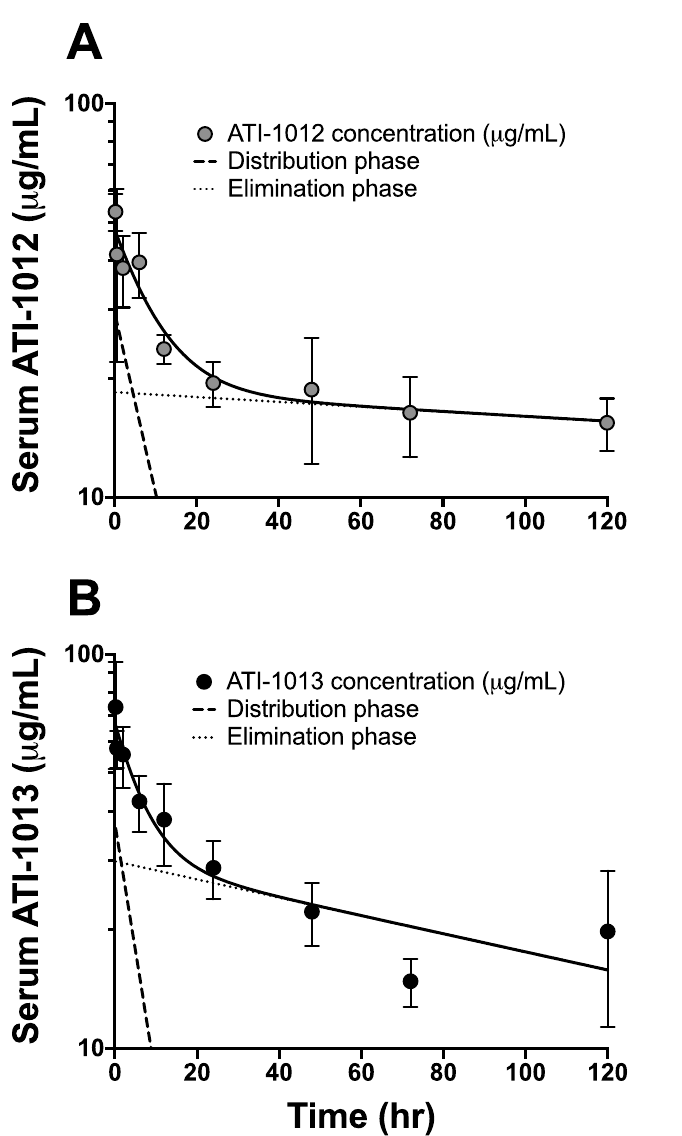
Fig 4. Pharmacokinetics of ATI-1012 and ATI-1013 in rats. Female SD rats were obtained with a jugular venous catheter in place. Rats (n = 3/group) received 5 mg/kg i.v. ATI-1012 (Panel A) or ATI-1013 (Panel B) via tail vein. Blood (0.4 mL) was collected into serum separator tubes via the jugular catheter at pre-dose, at 10 and 30 min, and at 2, 6, 12, 24, 48, 72, and 120 h. Noncompartmental analysis (PKSolver) of ATI-1012 and ATI-1013 showed elimination half-lives of 493 h and 131 h, respectively. Data are expressed as mean ±